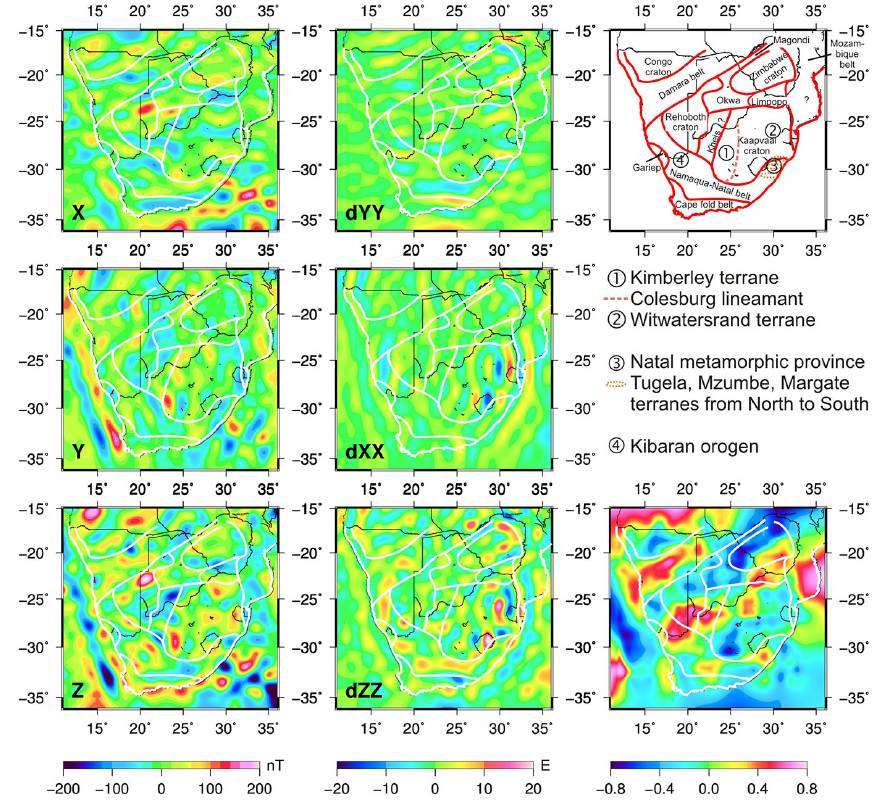
Figure 8. Comparison of long-wavelength magnetic and gravity anomalies for the southern African region. Left: lithospheric field from EMM2010 model of SH degrees 15–200 for north ( X ), east ( Y ), and vertical ( Z ) components from top to bottom. Middle: gravity gradients in north ( dYY ), east ( dXX ), and vertical ( dZZ ) directions from top to bottom from GOCE-DIR5 model up to SH degree 200. Right: labelled outline of large-scale tectonic features (top) after Thomas et al. (1993) and Webb (2009) and correlation between vertical component magnetic and gravity anomalies